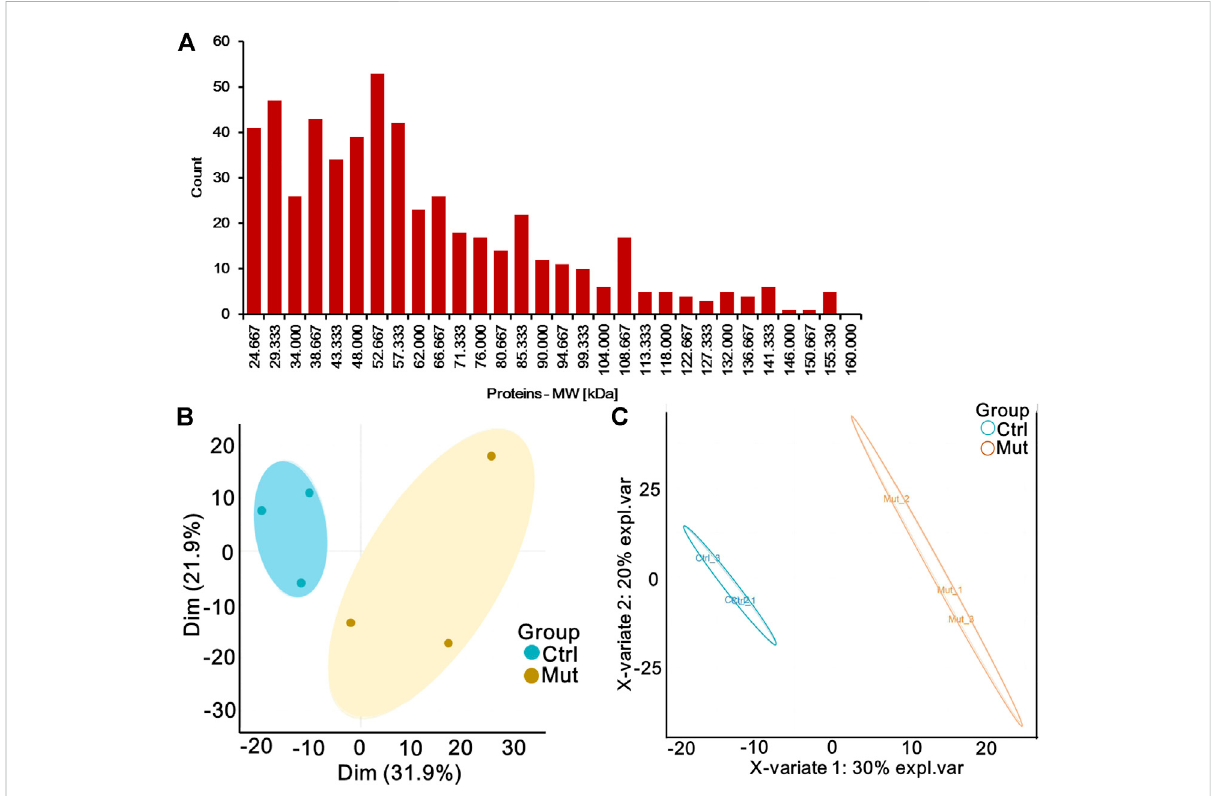
FIGURE 1 Quantitative proteomic pro fi ling of serum of patients with MMA by iTRAQ labeling. (A) Histogram of the distribution of the average molecular weight of protein. (B) Principal component analysis (PCA) diagram of six samples. Oval indicates the 95% con fi dence intervals. (C) Partial least- squares discriminant analysis (PLS-DA) diagram of six samples based on all proteins. Oval indicates the 95% con fi dence